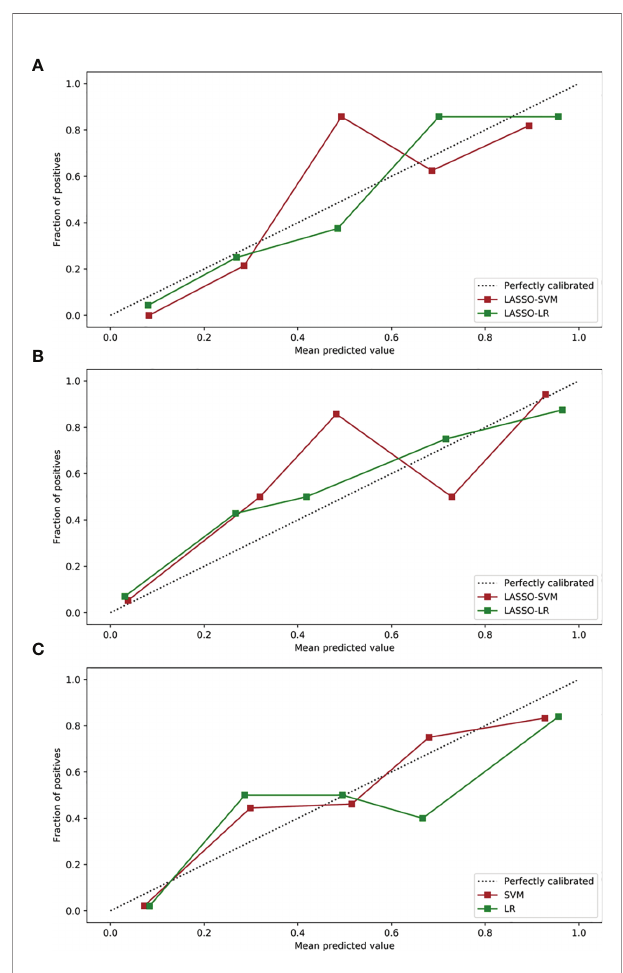
FIGURE 6 | Calibration curves of radiomics and combined models in the test sets. (A) Calibration curves of radiomics models based on arterial phase. (B) Calibration curves of radiomics models based on a three-phase combination. (C) Calibration curves of combined models. LASSO, least absolute shrinkage, and selection operator; SVM, support vector machine; LR, logistic